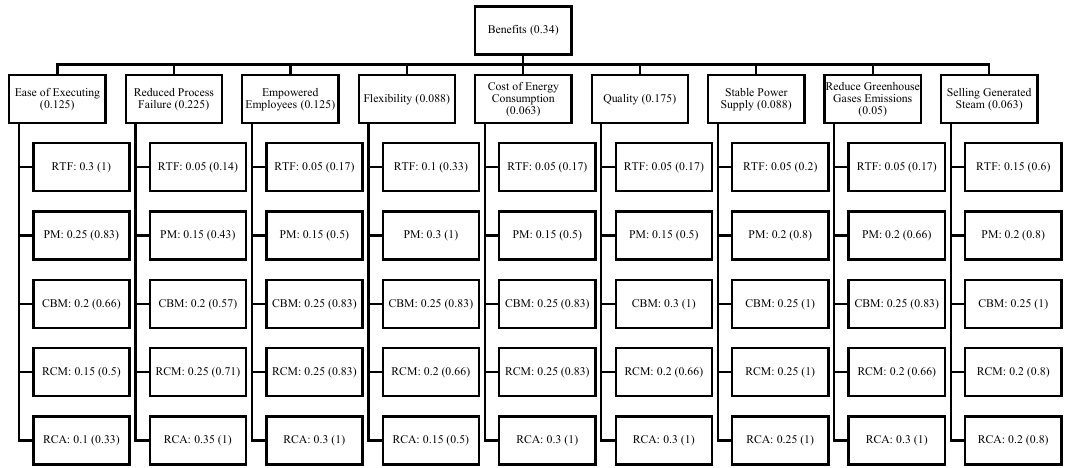
Fig. 3. Hierarchy chart of evaluated benefits and alternatives Opportunities